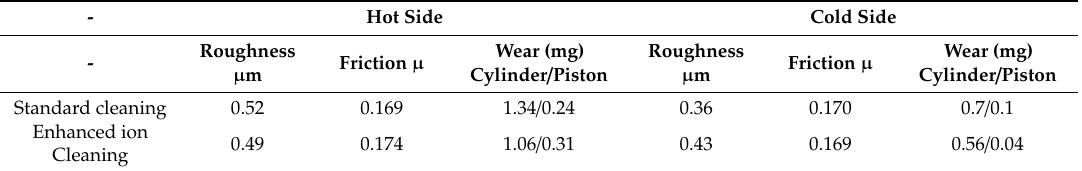
Table 1. Enhanced ion cleaning effects on roughness and tribological performance.